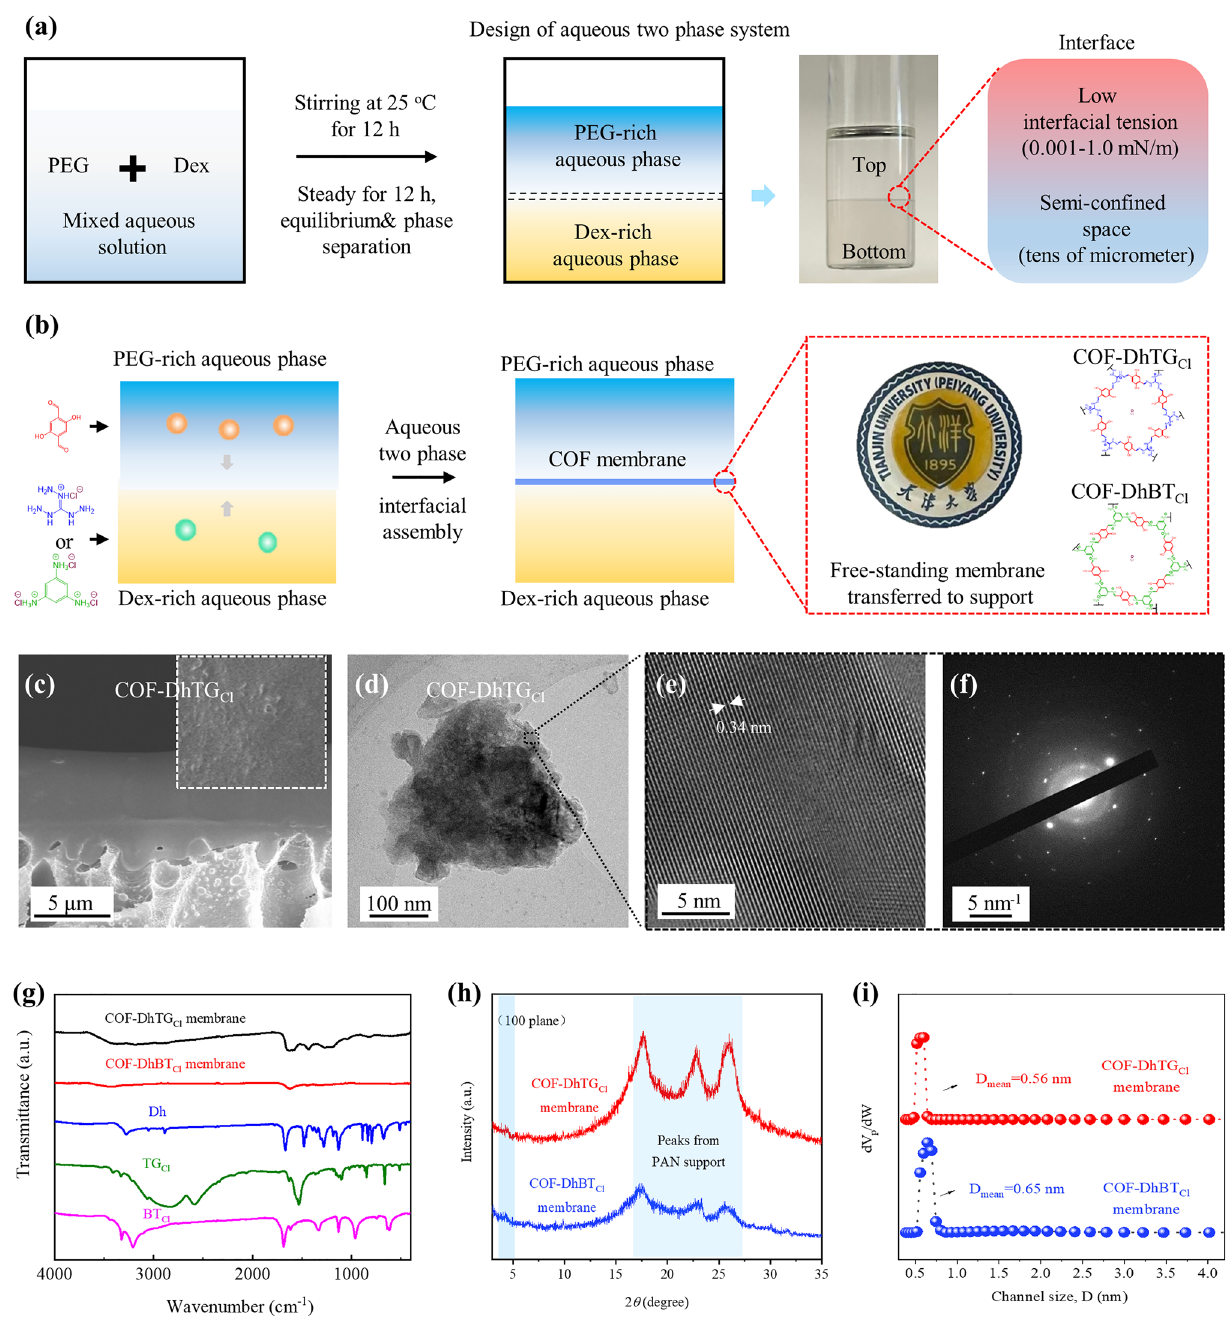
Fig. 1 Fabrication and morphology characterization of COF membranes. a Designing process for ATPS. b Aqueous two-phase interfacial assembly of COF membranes. c SEM, c‑d TEM and f SAED measurements on COF-DhTG Cl membrane. g FT-IR pattern, h GIWAXS pattern and i pore size distribution of COF